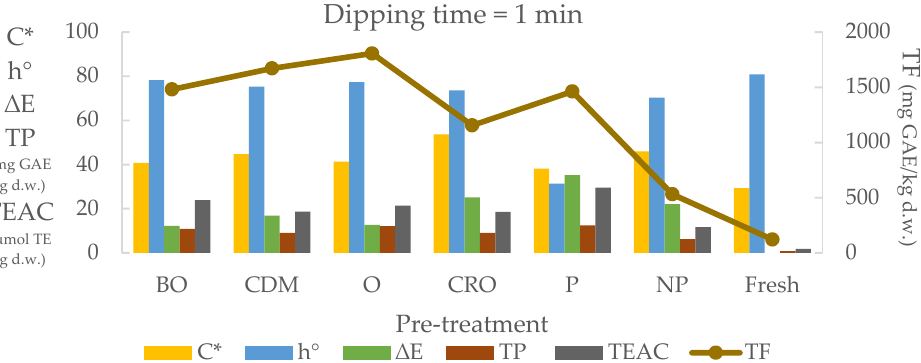
Figure 9. Effects of 1 min dipping time on quality parameters (tangerine ( Citrus deliciosa Mediterranean) (CDM); orange (O); bitter orange (BO); tangerine ( Citrus reticulate Owari) (CRO); pomegranate (P); non-pre-treatment (NP)].